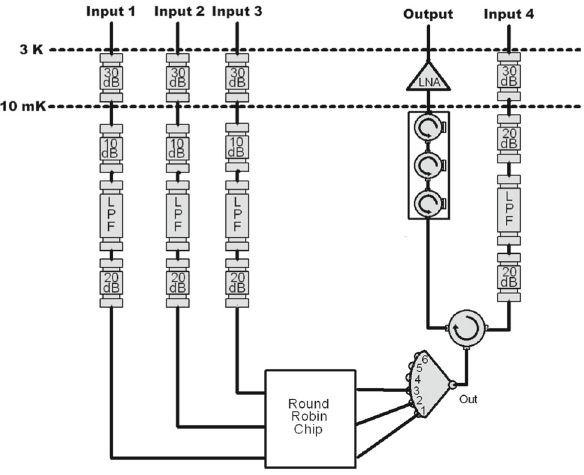
Fig. 3 Electronics setup for the Round Robin chip. The input lines are attenuated using 30dB attenuators at 3K and (10 + 20)dB attenuators at base temperature; moreover, they are filtered using 12GHz low-pass filters (“LPF”). The output signal is amplified using a 4–8 GHz